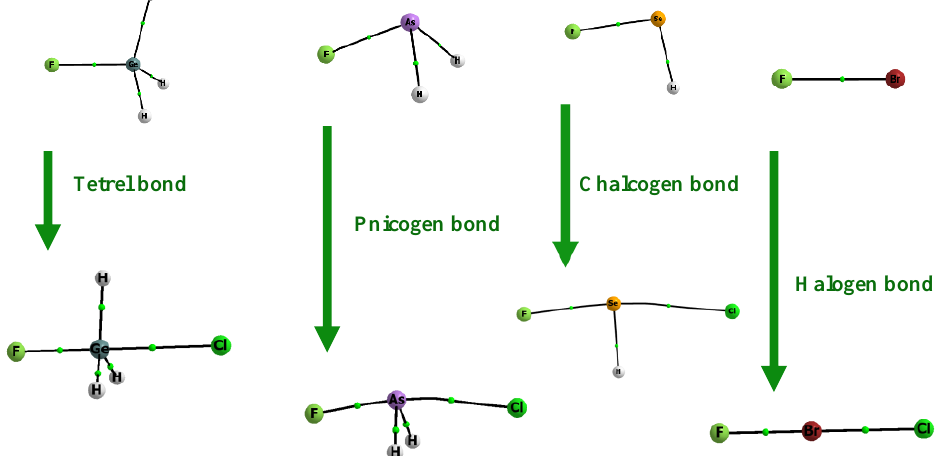
Figure 4. Molecular graphs of the Lewis acid units and the corresponding complexes (Z centre is of the fourth row of the periodic system). The big circles correspond to attractors (related to the atoms’ positions) and the small green circles to bond critical points; attractors are connected by bond paths.